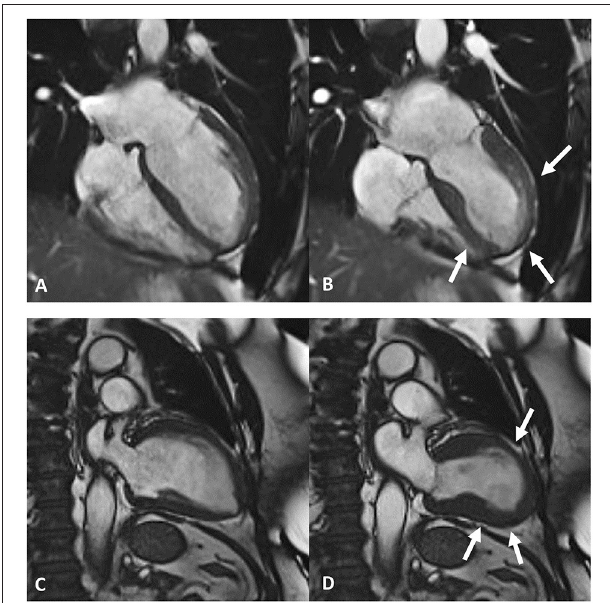
FIGURE 3 | Frames taken from cardiac magnetic resonance cine imaging. Top row, end-diastolic (A) and end-systolic (B) frames depict apical ballooning of the left ventricles (white arrows in B ). Bottom row, end-diastolic (C) and end-systolic (D) frames depict mid-ventricular ballooning of the left ventricles (white arrows in D